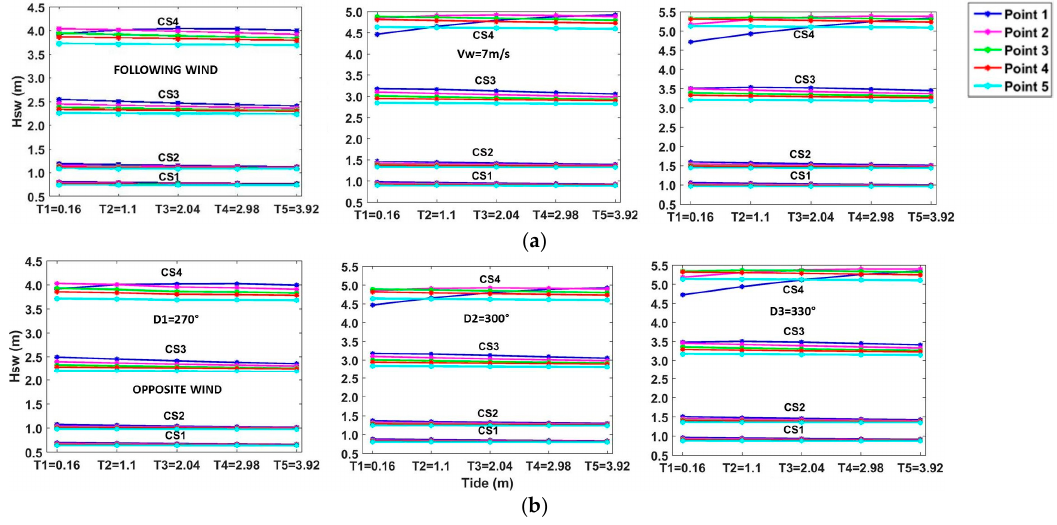
Figure 10. Average wind conditions ( V w = 7 m/s): H sw variations along the reference points corresponding to the three different directions of the incoming waves (D1, D2, D3) and to the five tide conditions (T1, T2, T3, T4, and T5) for all the case studies considered (CS1, CS2, CS3, CS4): ( a ) following wind; and ( b ) opposite wind.